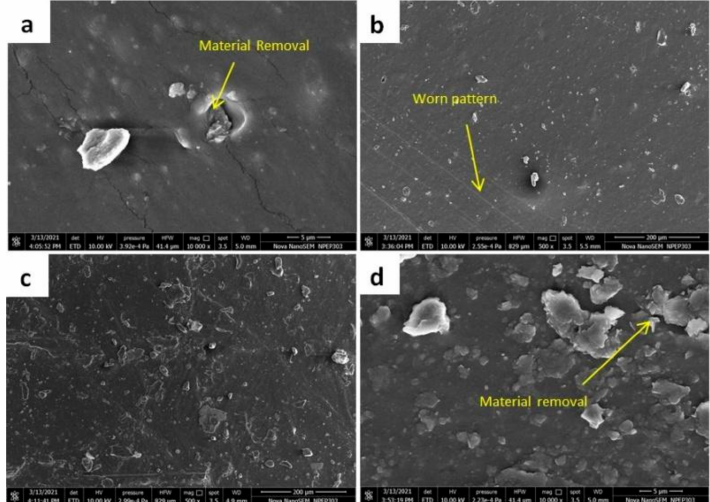
Figure 10. Worn Surface Morphology for ( a ) SR1 ( b ) SR2 ( c ) SR3 and ( d ) SR4 composition after wear test for a load of 40 N and sliding speed of 5 m/s.